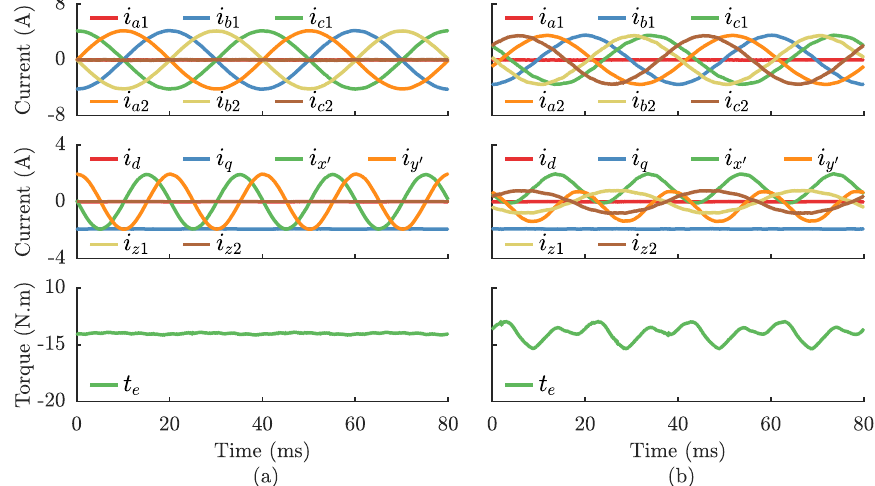
Figure 10. Experimental results for the six-phase drive under fault-tolerant mode due to an OPF in phase a 1, operating at 750 rpm, 50% load level, and under: ( a ) 2N configuration; ( b ) 1N